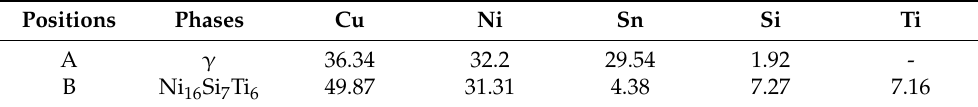
Figure 7. SEM micrographs of the Cu-15Ni-8Sn-0.3Si-0.1Ti alloy after annealing at 1093 K for 2 h. Intergranular micron particles are highlighted by the yellow dotted line. Table 4. EDS results of corresponding positions in Figure 7 (wt.%).